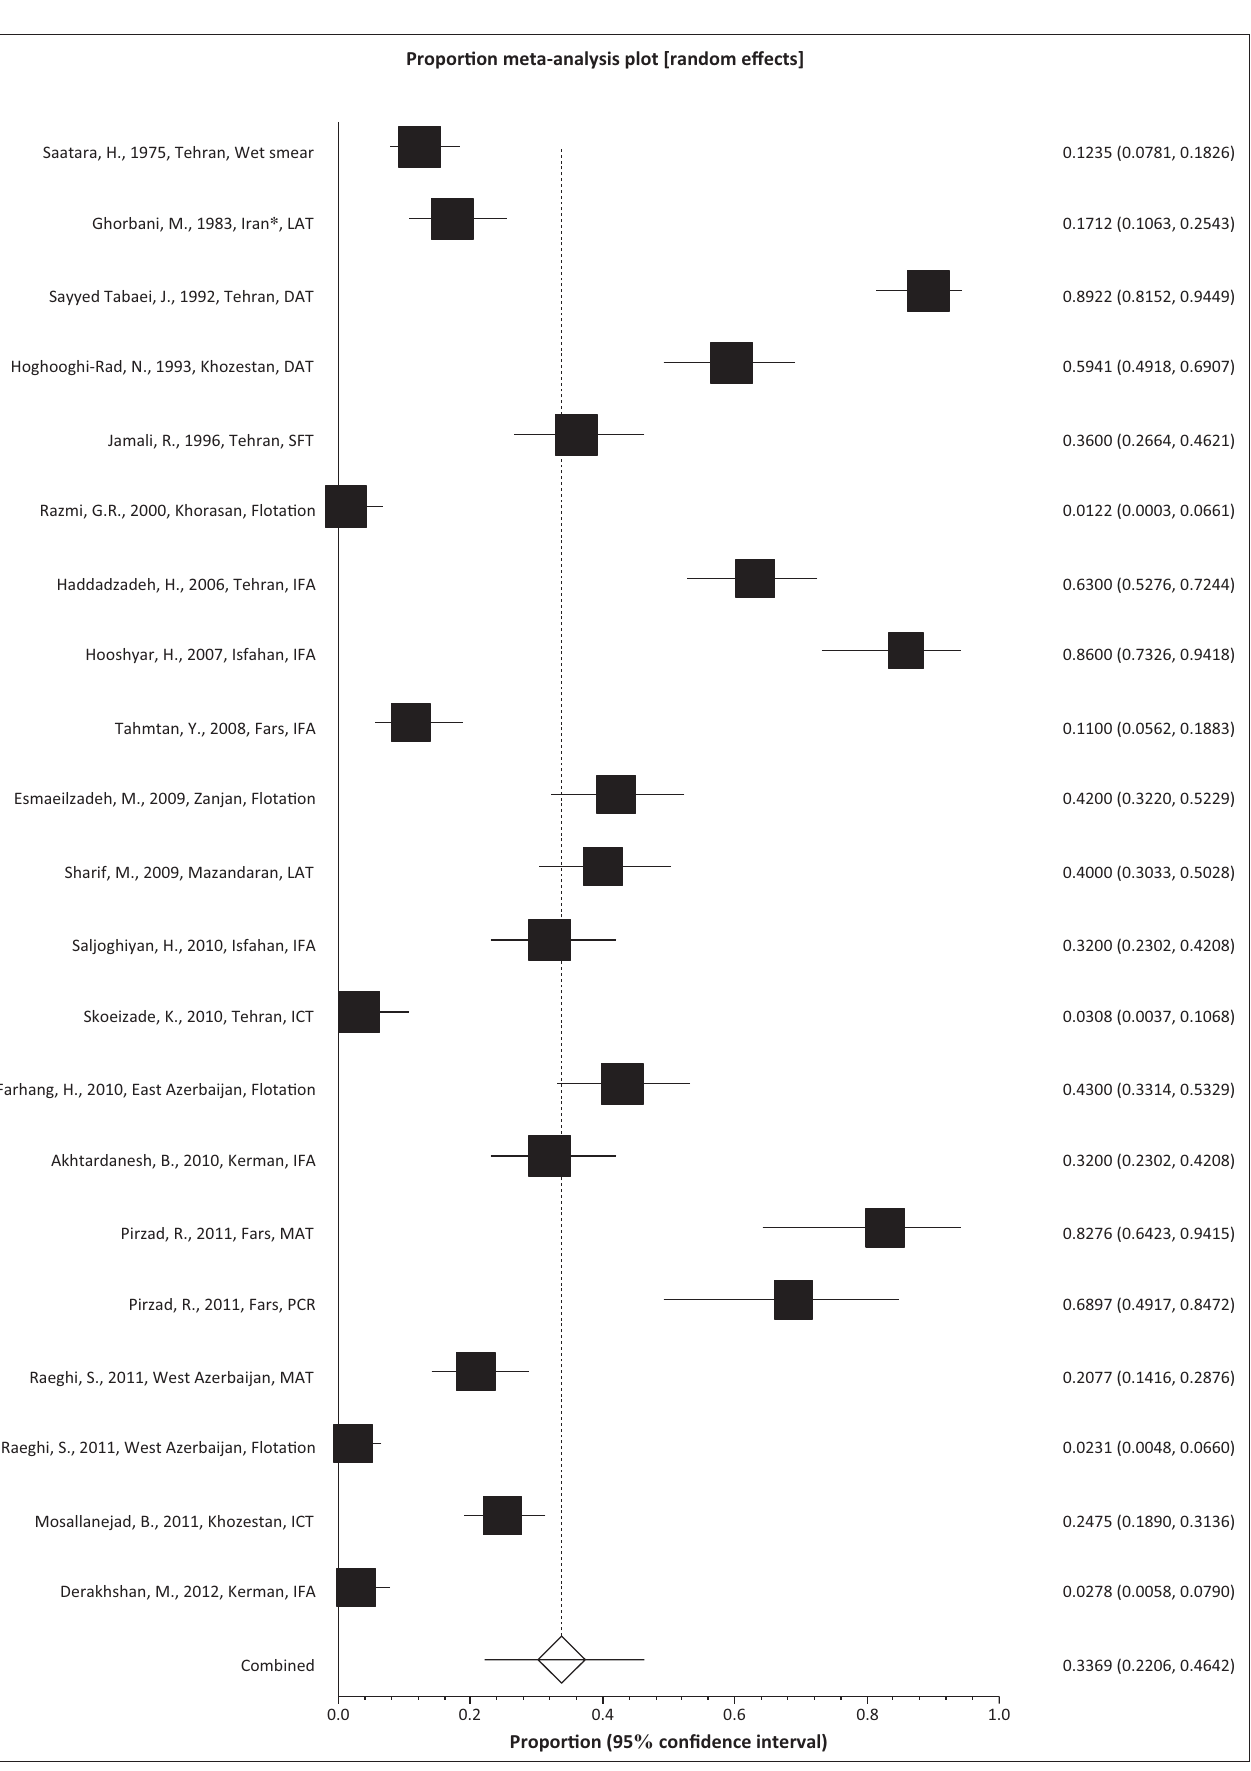
FIGURE 2: Forest plot diagram of the current systematic review and meta-analysis.